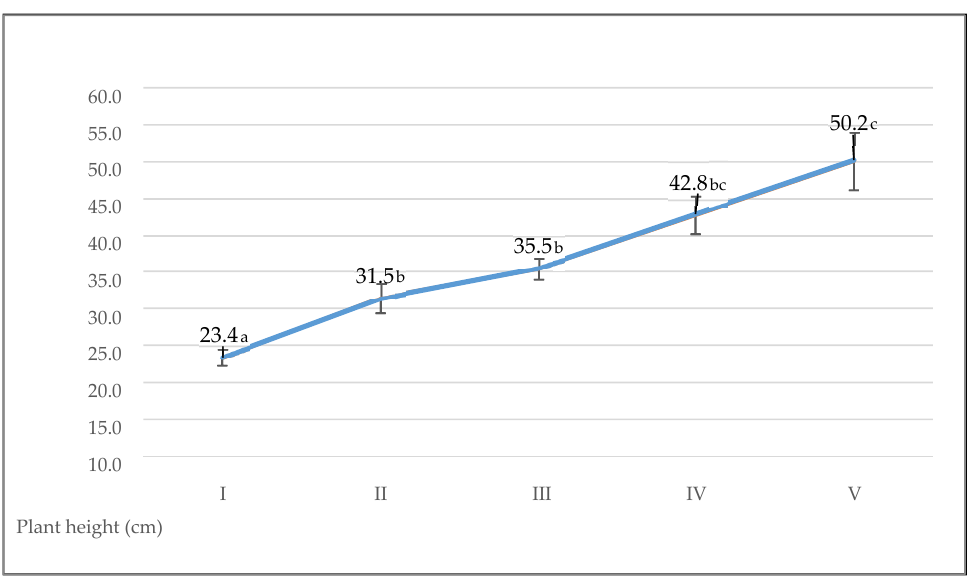
Table 3. Productive performances of Camelina sativa harvested during phenological stages (average between the two test years) (mean ± standard error).